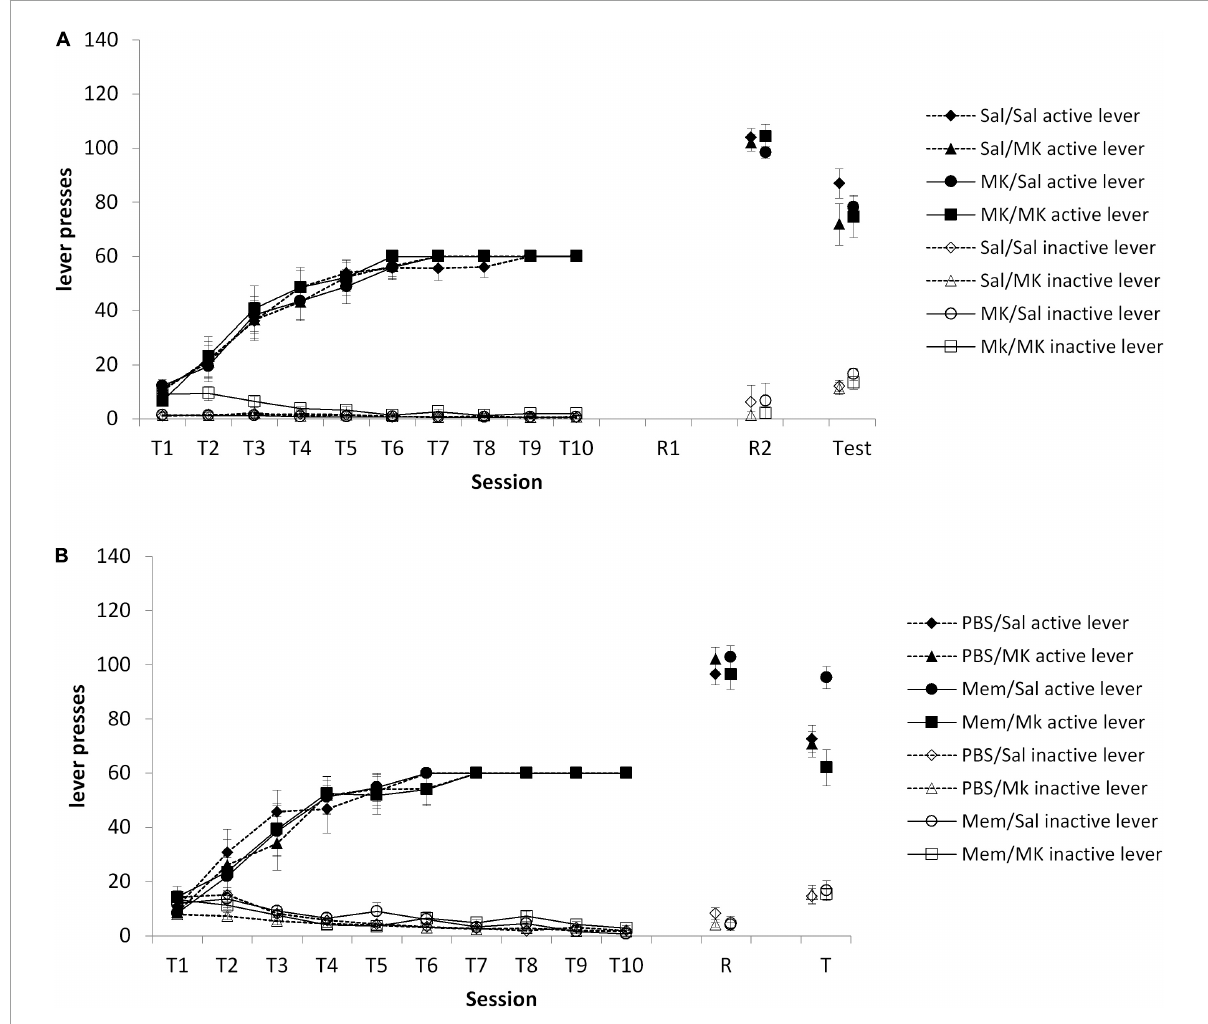
FIGURE4 (A) No obvious impact of MK-801 when administered prior to either or both of two consecutive reactivation sessions. Rats were trained to press an active lever for sucrose reward across 10 days (T1–T10) and then received two VR5 reactivation sessions (R1 and R2) following MK-801 or Saline injection. There was no obvious difference between MK/MK ( n = 12), MK/Sal ( n = 14), Sal/MK ( n = 14), and Sal/Sal ( n = 13) treated rats across any phase of the experiment. (B) Discriminated lever pressing at test (T) was impaired in the memantine group, but the PBS controls. Rats were trained to press an active lever for sucrose reward across 10 days (T1–T10) and received an Memantine or PBS injection 24 h after training, then received one VR5 reactivation session (R) following MK-801 or Saline injection. In the memantine injected groups, MK-801 treated